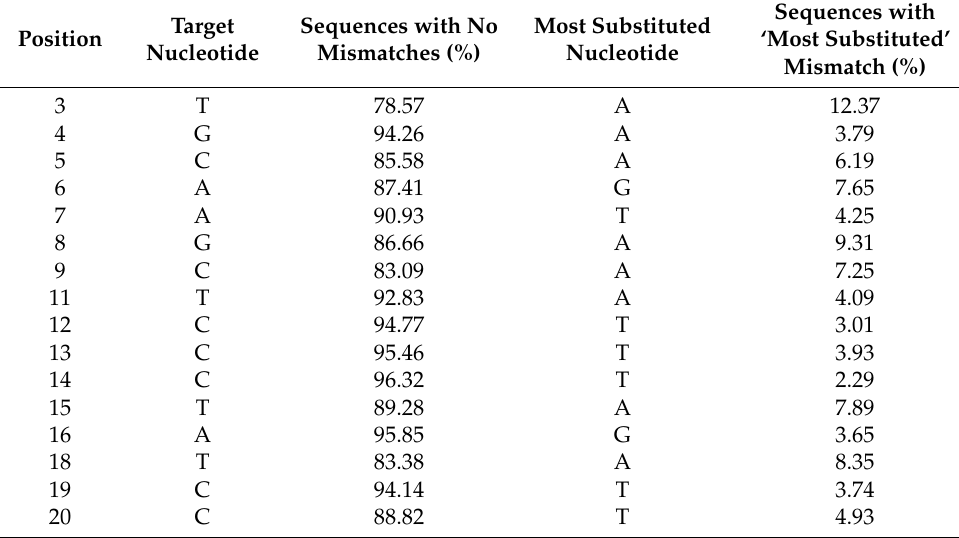
Table 1. Position–nucleotide pairs with the least mismatch tolerance.